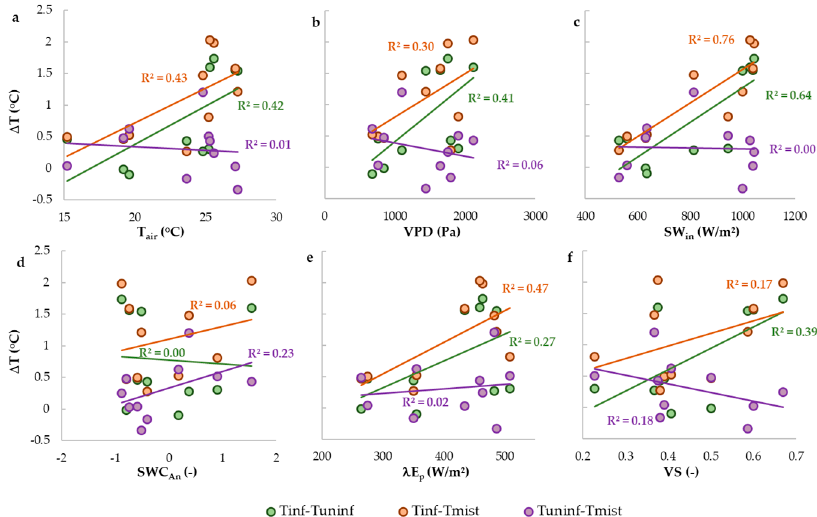
Figure 6. Distribution of the differences between infected (T inf ) and uninfected (T uninf ) eucalypt canopy temperature, between infected eucalypt and mistletoe (T mist ) canopy temperature and between uninfected and mistletoe canopy temperature as a function of climatic drivers ( a ) air temperature, ( b ) vapor pressure deficit and ( c ) incoming shortwave radiation), ( d ) the normalized anomaly in soil water content, ( e ) potential evaporation and ( f ) the vegetation stress factor.